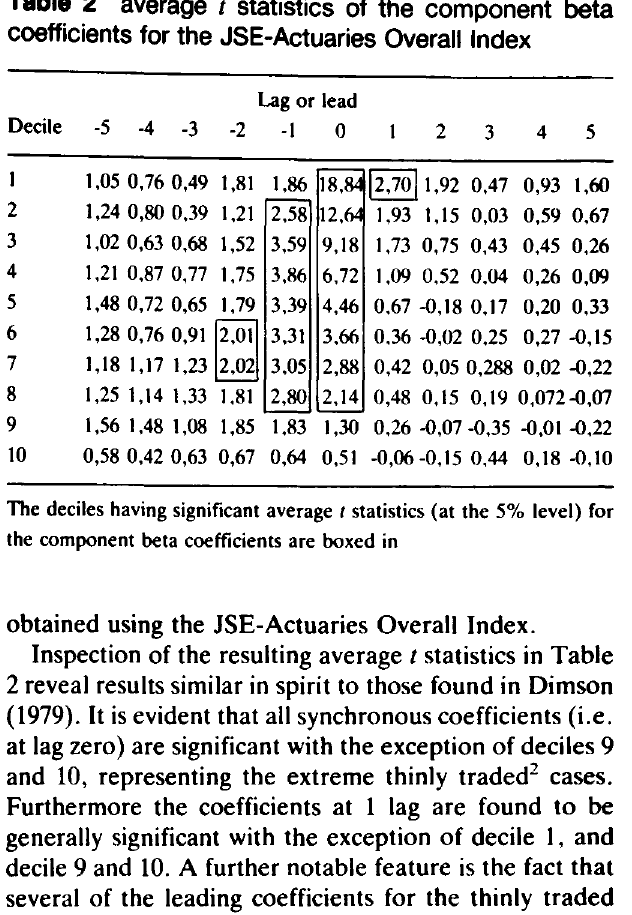
Table 1 Average component beta coefficients for the